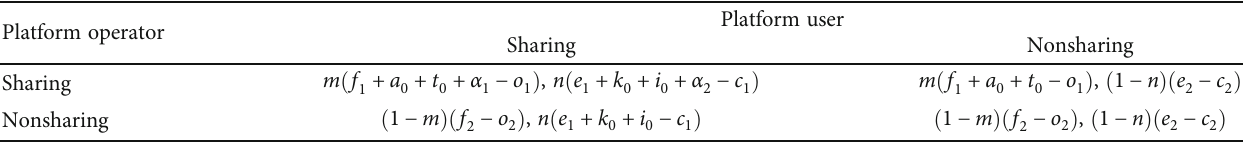
Table 3: Evolutionary game return